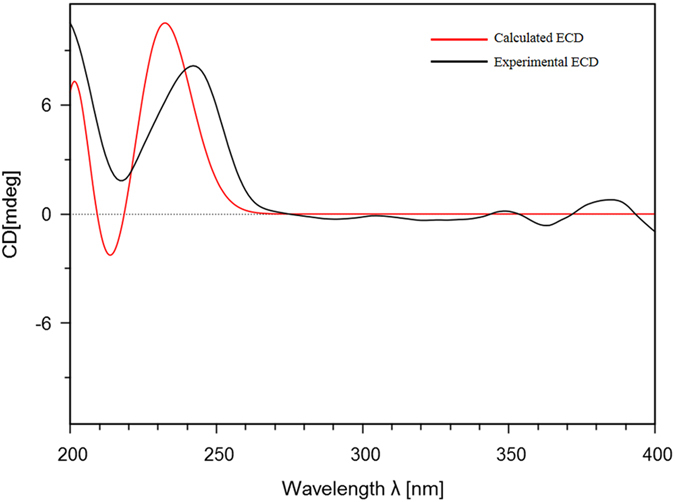
Theoretically calculated and experimentally determined ECD of 8.